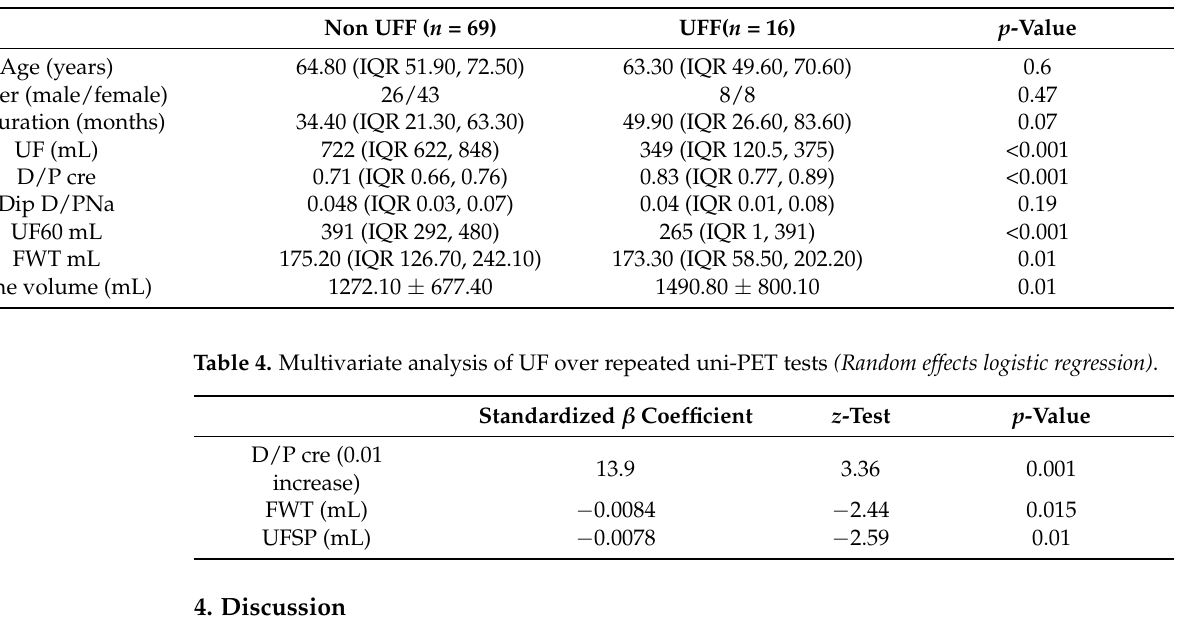
Figure 1. Changes of membrane characteristics over time in patients with UFF and non-UFF; ( A ) D/Pcre, ( B ) Free Water and Transport ( C ). Ultrafiltration through small pores (UFSP). Table 3. A comparison between patients with non-ultrafiltration failure (UFF) vs. UFF.